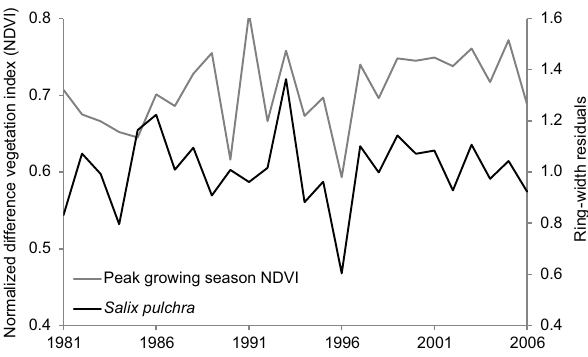
Fig. 3. The grey line shows peak growing season (2nd half July) greenness (NDVI) values for the Kytalyk research area in NE- Siberia. NDVI was calculated as the average of four pixels, with each pixel giving a NDVI value for an area measuring 8 by 8km. The black line shows the Salix pulchra residual